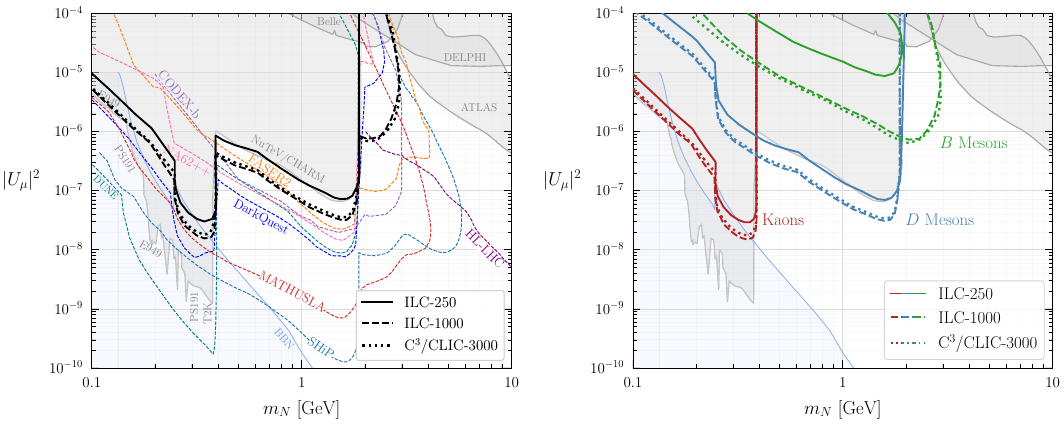
Figure 6 . Same as in figure 5 but for muon-mixed HNLs.